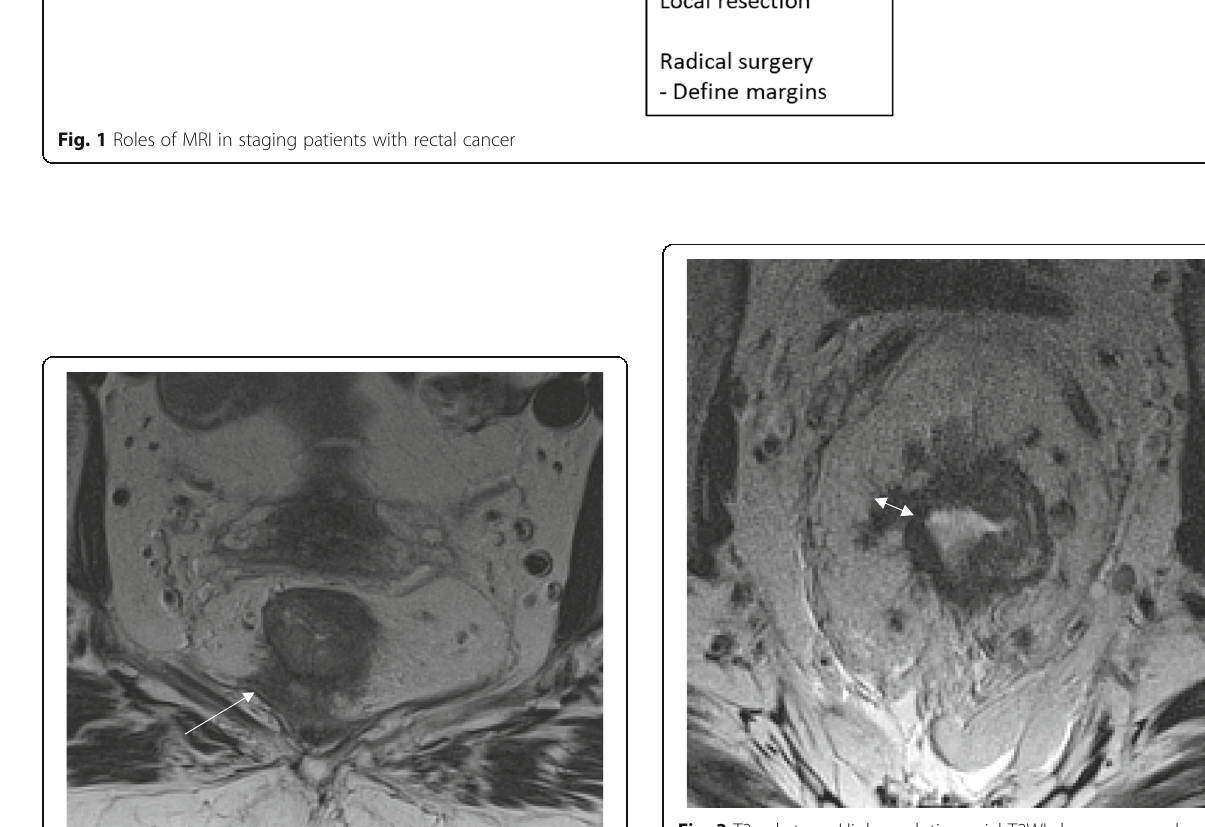
Fig. 3 T3 substage. High-resolution axial T2WI shows an annular tumor that extends beyond the muscularis propria. The measurement of the 9-mm spread was taken at the infiltrative border of the lesion at 9 o ’ clock